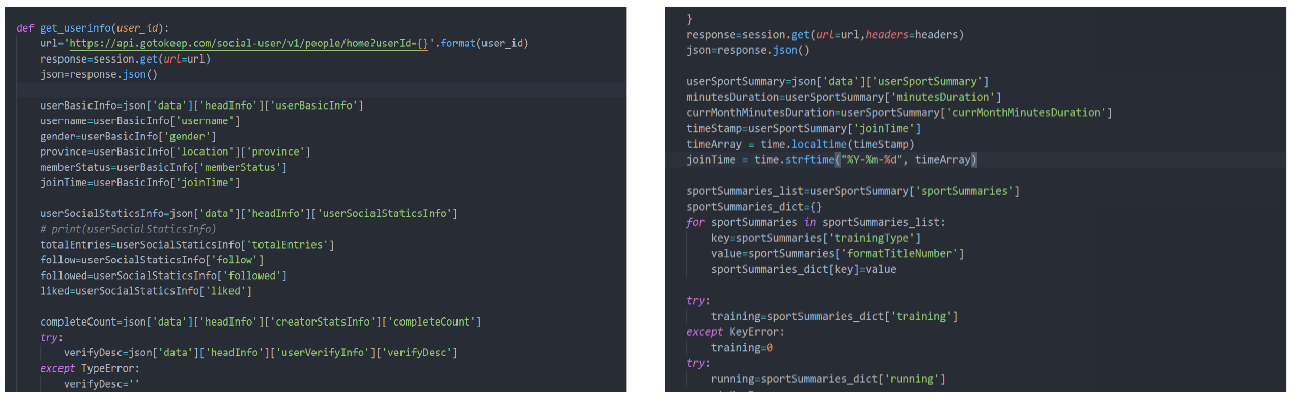
Figure 3. Data crawler.